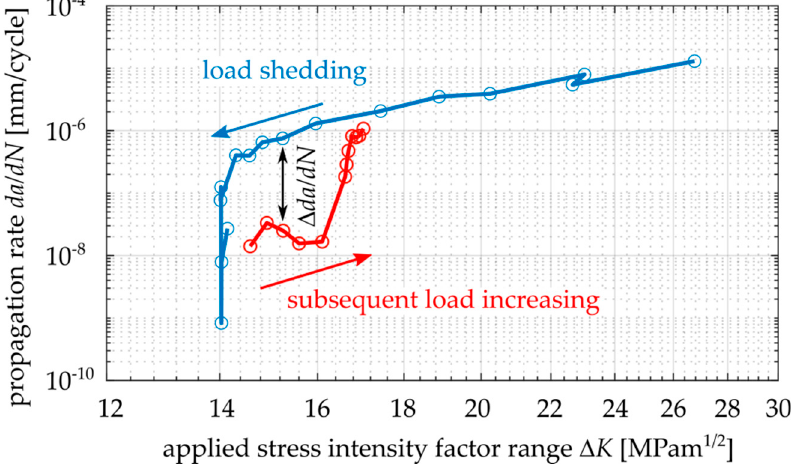
Figure 2. Fatigue crack retardation after load shedding procedure in da/dN-K max curve, data experimentally obtained for Cr-Mo low-alloy steel, R = − 1.